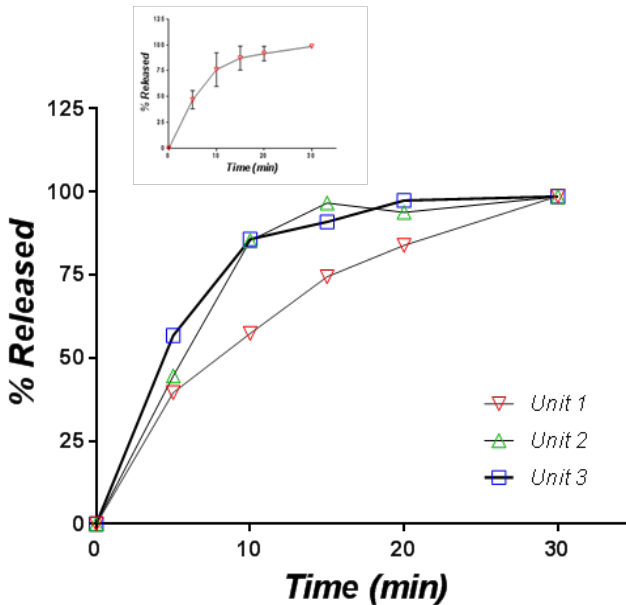
Figure 11. Individual and mean (inset) in vitro release profiles of captopril from orally disintegrating tablets containing the CAP- β -CD inclusion complex (medium: simulated saliva, 900 mL).